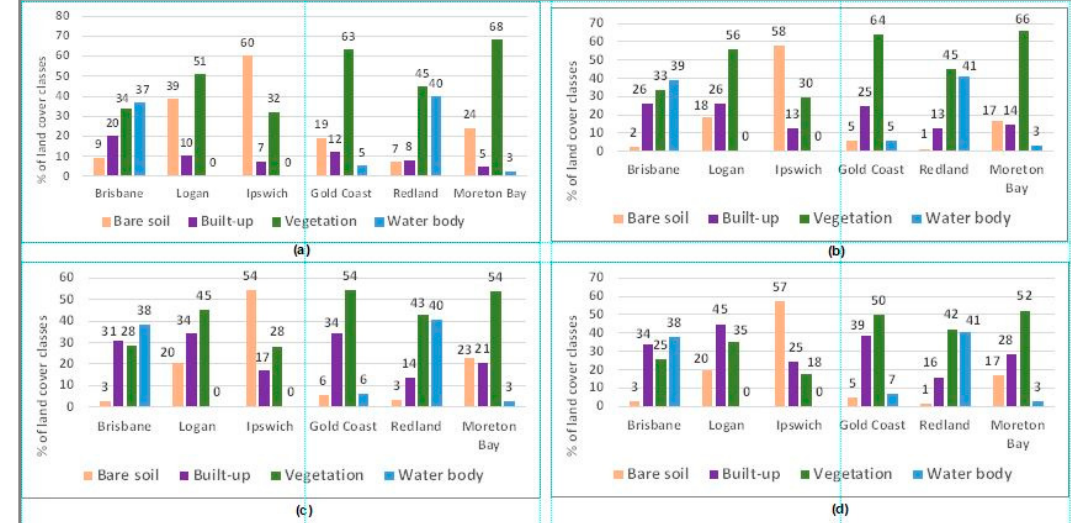
Figure 4. ( a ) % of local government area (LGA) share of total LULC changes for 1989; ( b ) % of LGA share of total LULC changes for 1999; ( c ) % of LGA share of total LULC changes for 2009; ( d ) % of LGA share of total LULC changes for 2019.